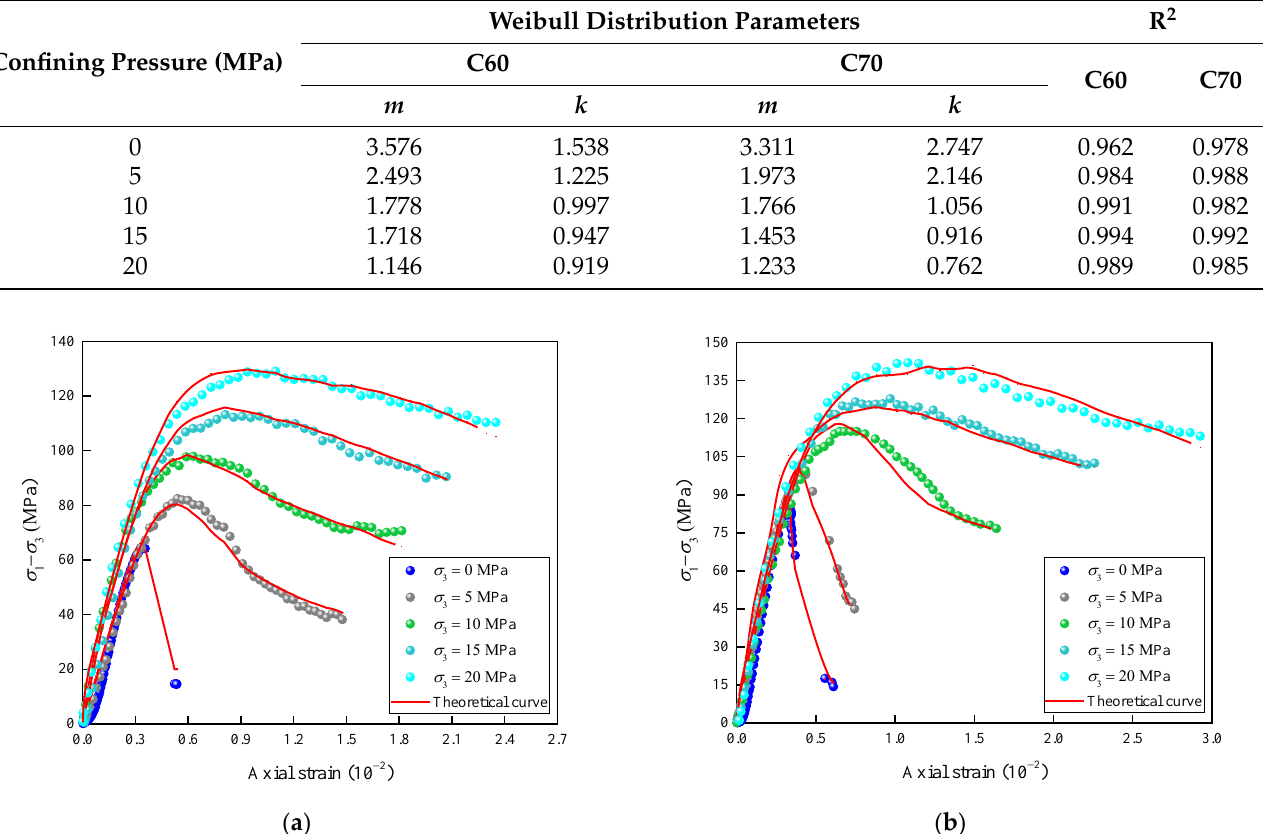
Table 4. Weibull distribution parameters m and k at different confining pressures.